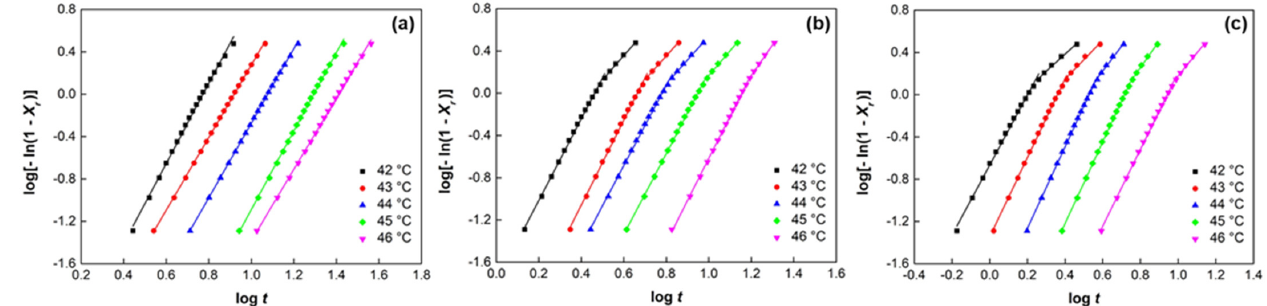
6 of 14 Figure 3. Half-time of crystallization vs. the crystallization temperature (average values with stand- ard deviation) for PCL and composites PCL-HGM ( a ) and PCL-HGMf ( b ).